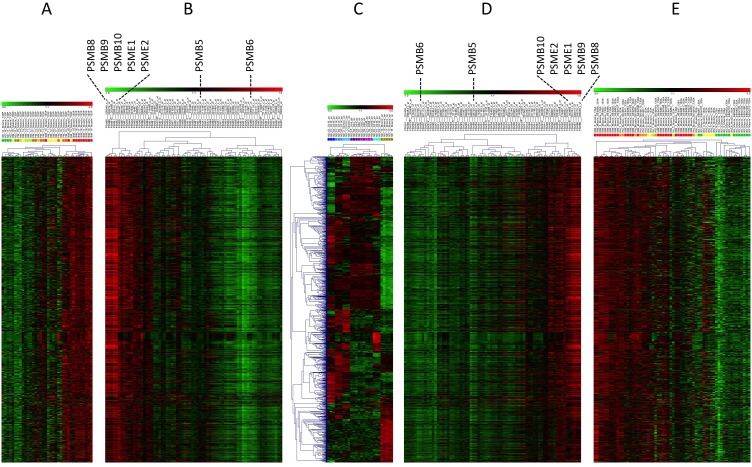
Correlation of proteasome subunit expression with myositis signatures and overlap with immune cell infiltration:Expression of all proteasome units were investigated in transcriptome data of muscle biopsies referenced in table S2 and were correlated with genes increased in myositis muscle tissue. The heatmap of the probeset signal intensities (A) is opposed to the heatmap of the gene by gene correlation matrix (B) in 133P array experiments. Identical analysis in 133A arrays are shown in D and E. Expression of the 1209 probesets in reference transcriptomes of purified immune cells from the blood of healthy donors served as basis for clustering by probesets and cell types (C). Identification of cell type specific transcriptional patterns in the 1209 probesets demonstrates the extent of overlap of these probesets with immune cell related transcripts. Myositis samples include IBM (red), PM (orange), DM (yellow), NM (necrotizing myopathy)/IM (inflammatory myopathy) (light green) and HD (green). Immune cell types include neutrophils (dark blue), monocytes (blue), dendritic cells (light blue), CD4+ T-cells (dark violet), CD8+ T-cells (violet), NK-cells (light violet), B-cells (cyan), and healthy muscle (moss-green). A detailed graph with all probesets labelled is presented in supplemental material (figure S4).